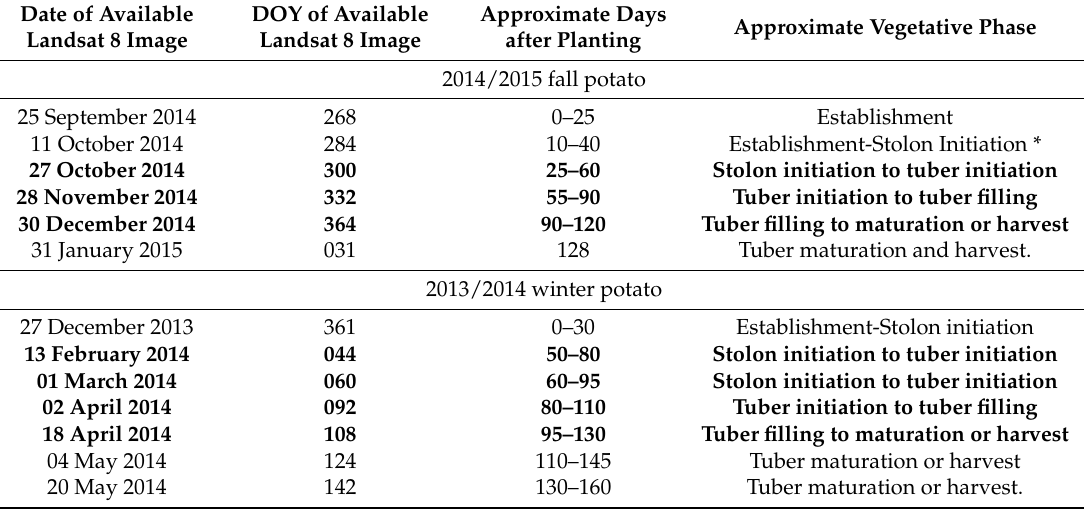
Table 3. Available L8 images corresponding to selected potato